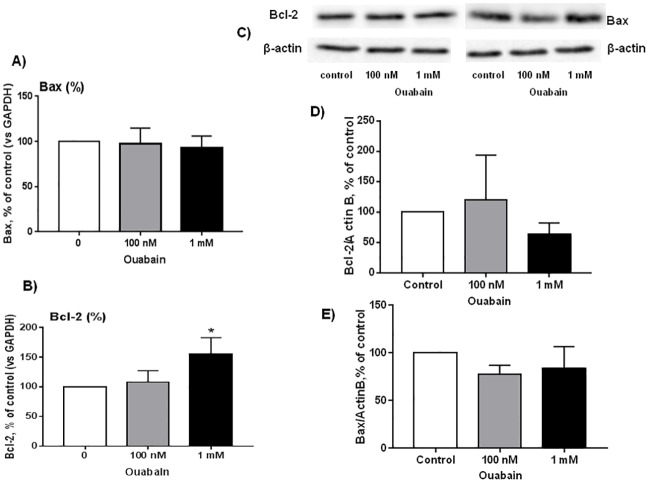
Effect of ouabain on content Bcl-2 and Bax mRNAs (A,B) and protein (C-E) in rat cerebellum granule cells.Cerebellum granule cells were incubated in the absence or presence 100 nM and 1 mM ouabain for 3 h. Bcl-2/GAPDH (A) and Bax/GAPDH (B) ratios in the absence of ouabain were taken as 100%. Representative Western blot (C) and Bcl-2/Actin B (D) and Bax/Actin B (E) ratio. Bcl-2/Actin B and Bax/Actin B ratios in the absence of ouabain were taken as 100%. Means ± SD for 4 independent experiments are shown. *—p<0.05.